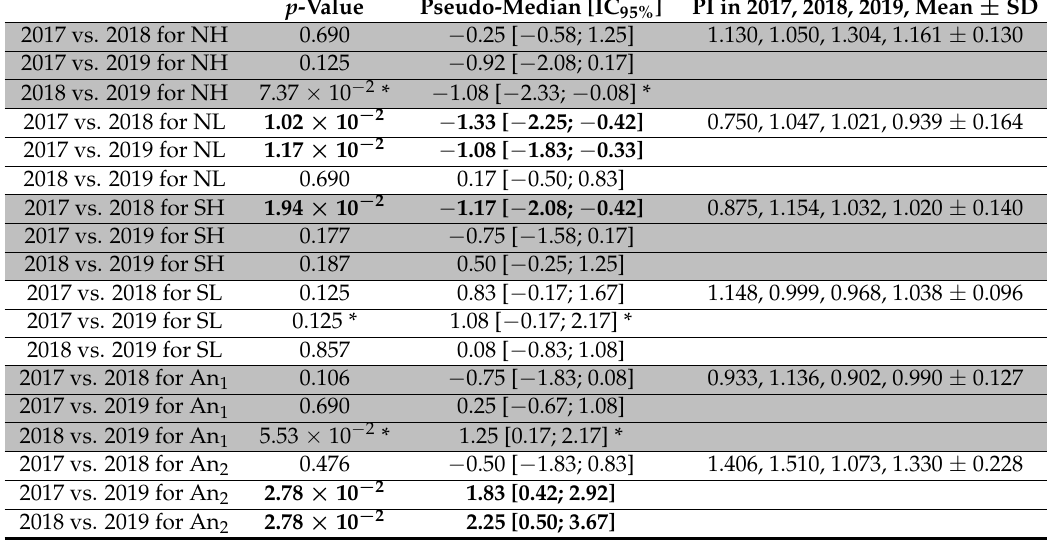
Table 5. Wilcoxon Signed Rank bilateral tests for paired samples on the inter-year level. p -values have been corrected by the FDR method and are shown in Figure 3. The pseudo-medians of the daily activity hours differences and their 95% confidence interval as well as the associated persistence indices (PI), annual mean, and standard deviation are also presented. Significant differences detected are in bold, an asterisk indicates those that are also seem biologically relevant. p -Value Pseudo-Median [IC 95%